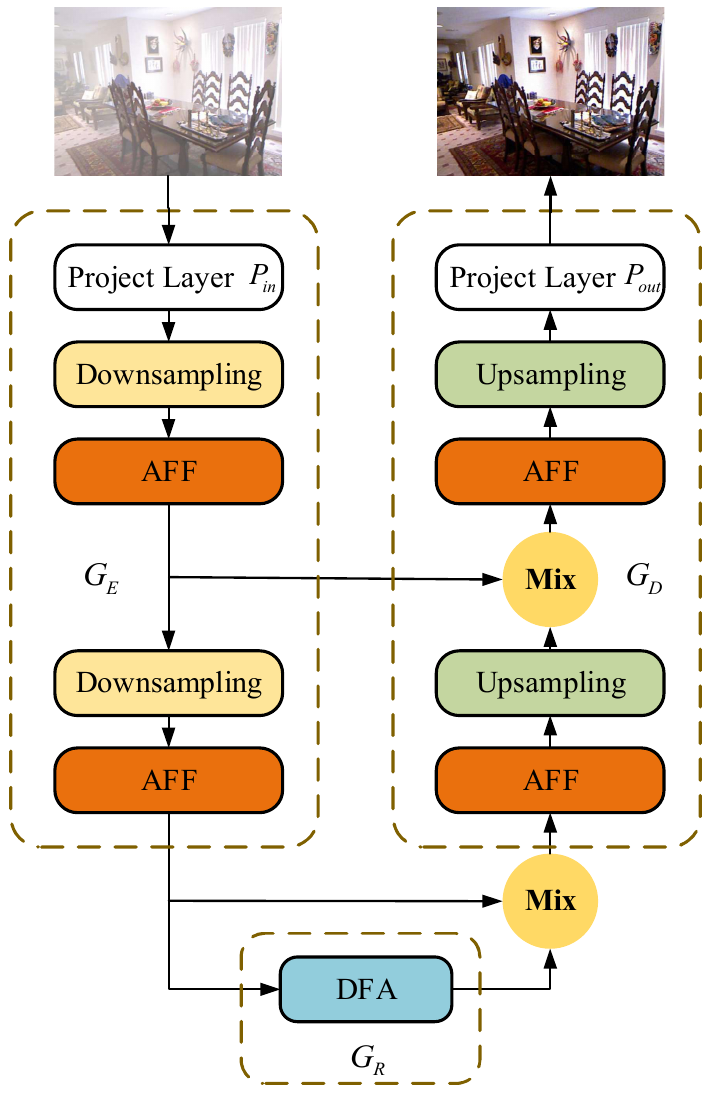
Figure 1. The structure of the proposed DMADN.